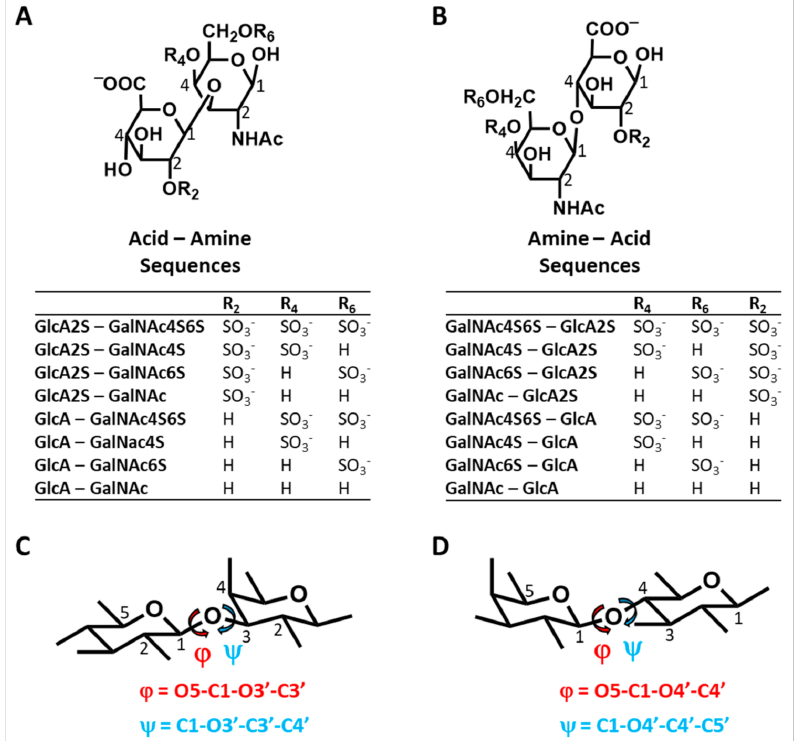
Figure 1. Structures of the two disaccharide classes of CS, i.e., Acid-Amine or β 1 → 3-linked ( A ) and or β 1 → 4-linked Amine-Acid ( B ), studied in this work. Each class consisted of 8 disaccharides with varying sulfation levels, indicated by the R 2 , R 4 and R 6 groups. The structures were generated in SYBYL with pre-defined experimental torsion angles marked phi ( ϕ ) and psi ( ψ ) based on structures available in the PDB (protein data bank). The definitions of torsional angles ϕ and ψ for each disaccharide of the two classes are provided in ( C , D